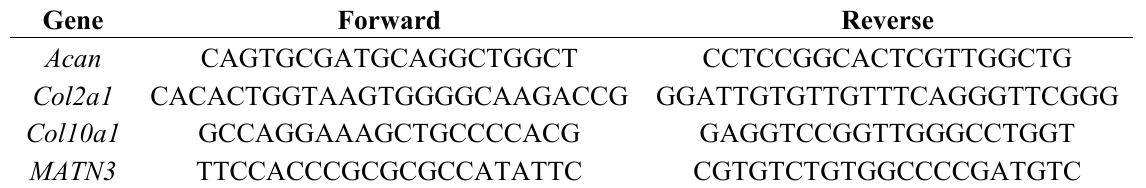
Table 2. Forward and reverse primer sequences used in gene expression